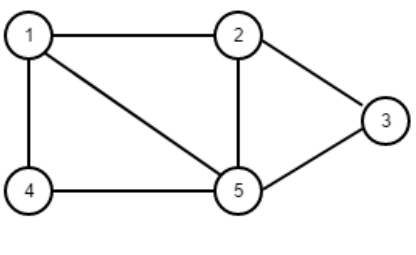
Figure 10. A graph containing five points.